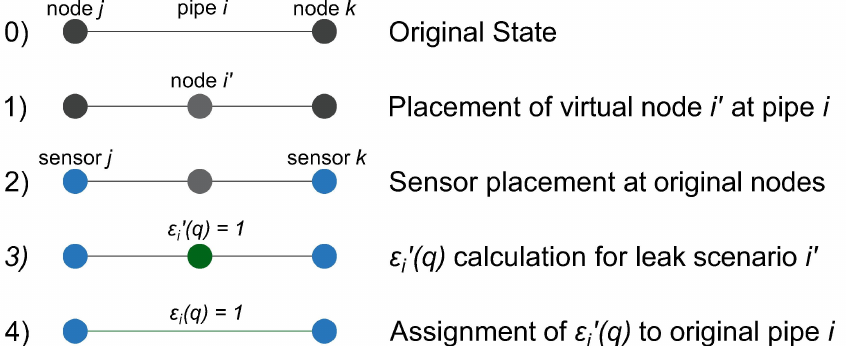
Figure 1. Process scheme of simulating leaks on pipes for Optimal Sensor Placement